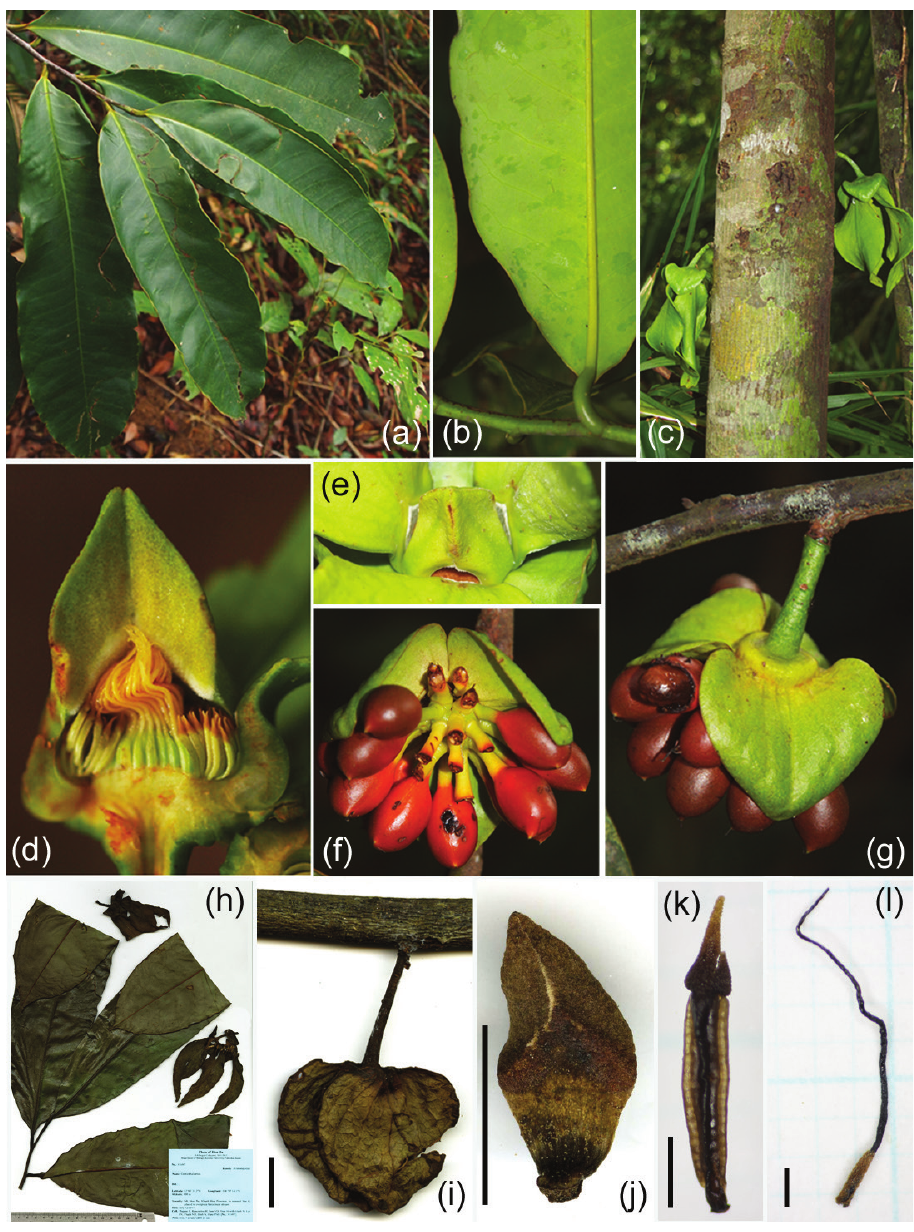
Figure 1. Goniothalamus flagellistylus sp. nov. ( a ) Leafy branch, ( b ) portion of abaxial leaf surface, ( c ) flowers on main trunk, ( d ) vertical section of flowers, ( e ) apertures between inner petals, ( f–g ) mature fruit on older blanch, ( h ) holotype, ( i ) pedicel and sepals on old branch, ( j ) adaxial side of inner petal, ( k ) stamen, ( l ) carpel. ( h–l ) From Tagane et al. 1497 . Scale bars ( i , j ) = 1 cm, ( k, l ) = 1